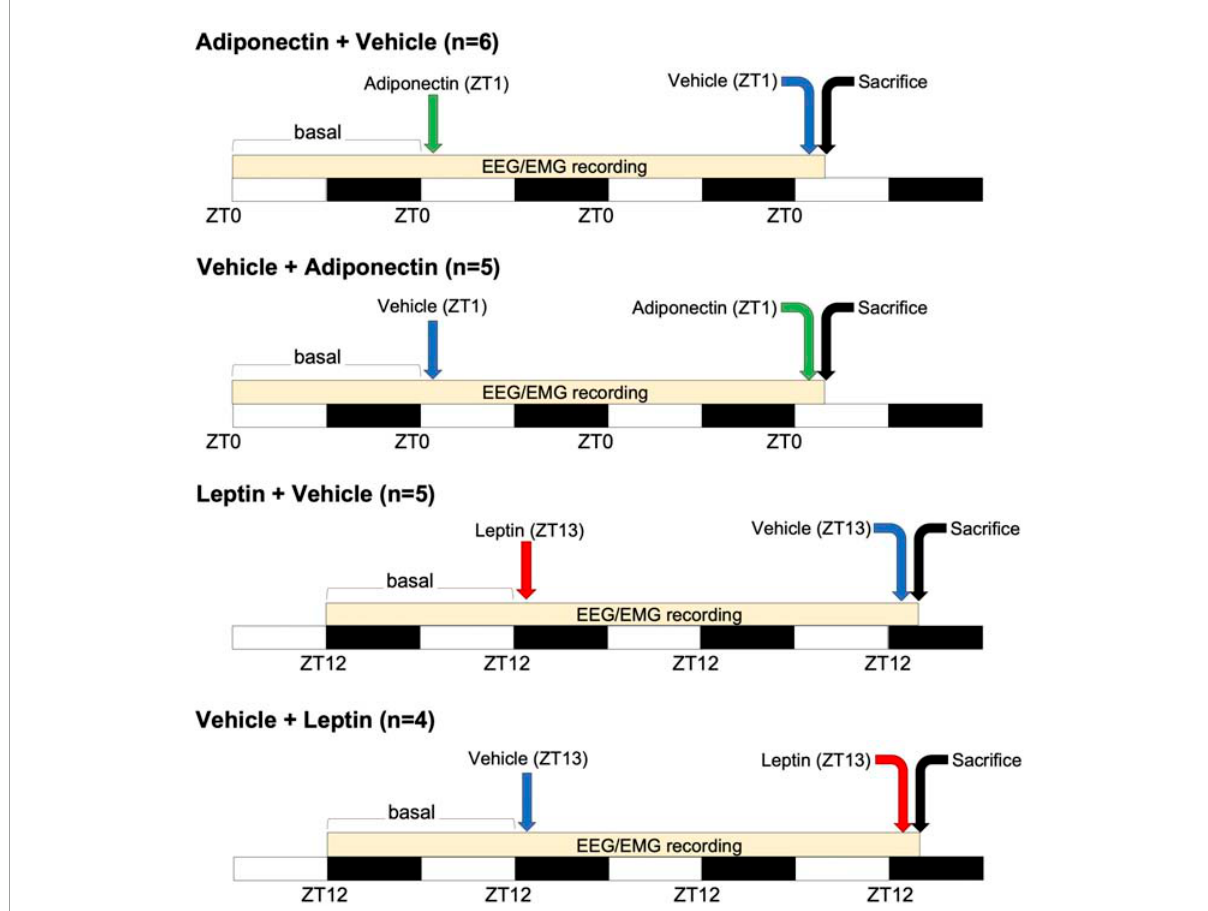
FIGURE1 Time-course of adipokines administration. Four groups of animals received microinjection of adiponectin (at ZT1, green arrow) or leptin (at ZT13, red arrow) alternating with the administration of vehicle (before or after adipokines injection, blue arrow). White and black bars indicate the light and dark period, respectively. A difference of 48 h occurs between adipokine and vehicle administration. EEG/EMG recording occurs at the onset of that basal period, during the following 23 h after the first microinjection and along the 2 h after the second one. Animals were sacrificed two h after the second microinjection as indicated by the black arrow. ZT, Zeitgeber time; EEG, electroencephalogram; EMG,